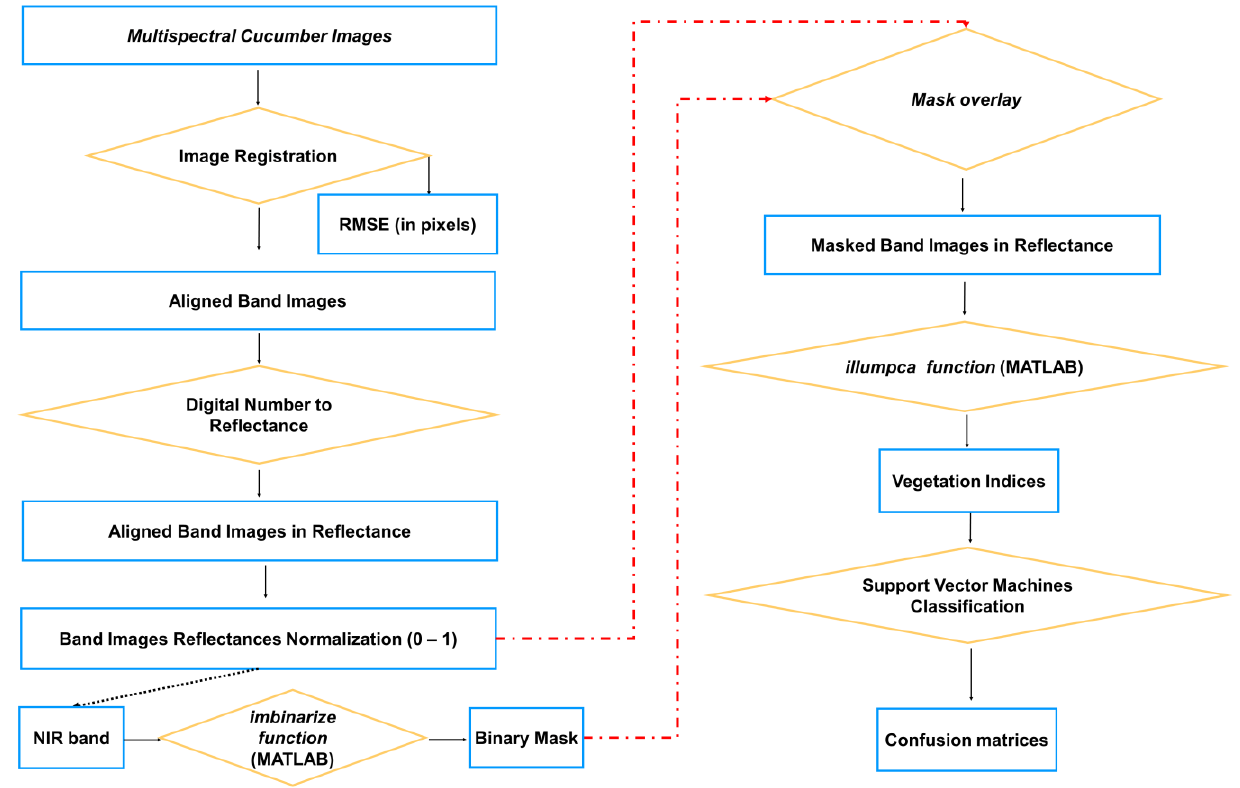
Figure 4. Flowchart of the image processing used in the study.